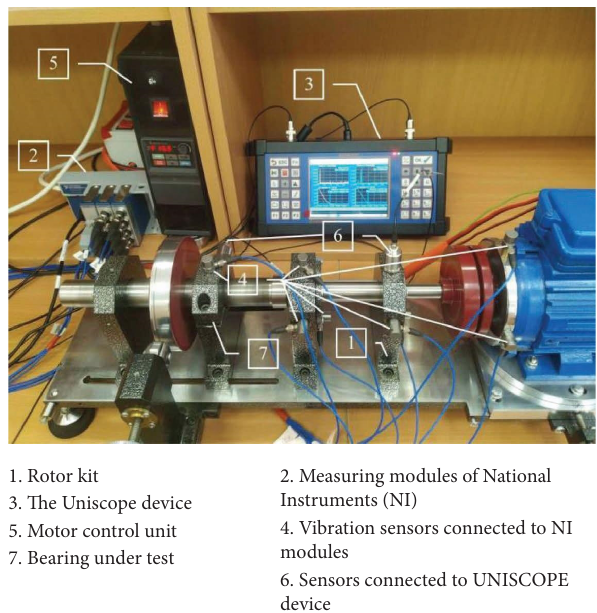
Figure 5: Rotor kit for studying the parameters of the VA signal and its CF.